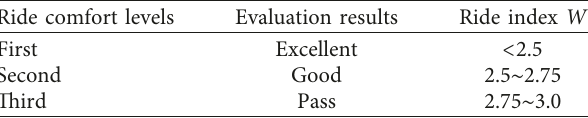
Table 1: Grades of running stability for the passenger